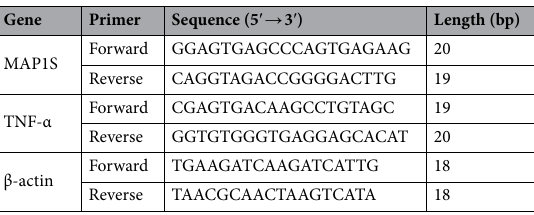
Table 4. Primers used for REAL-time